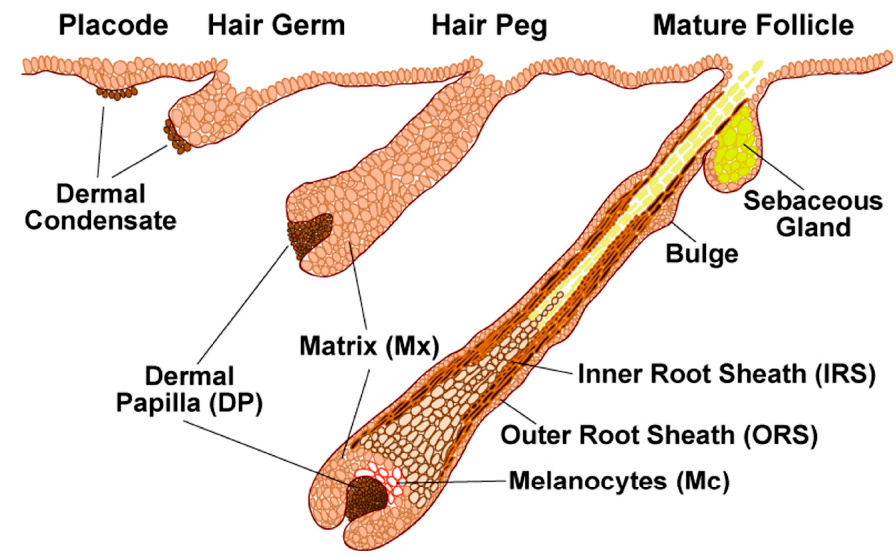
Figure 1. Embryonic stages of the human hair follicle morphogenesis. Reproduced with permission from [25], published by Rockefeller University Press, 2008.